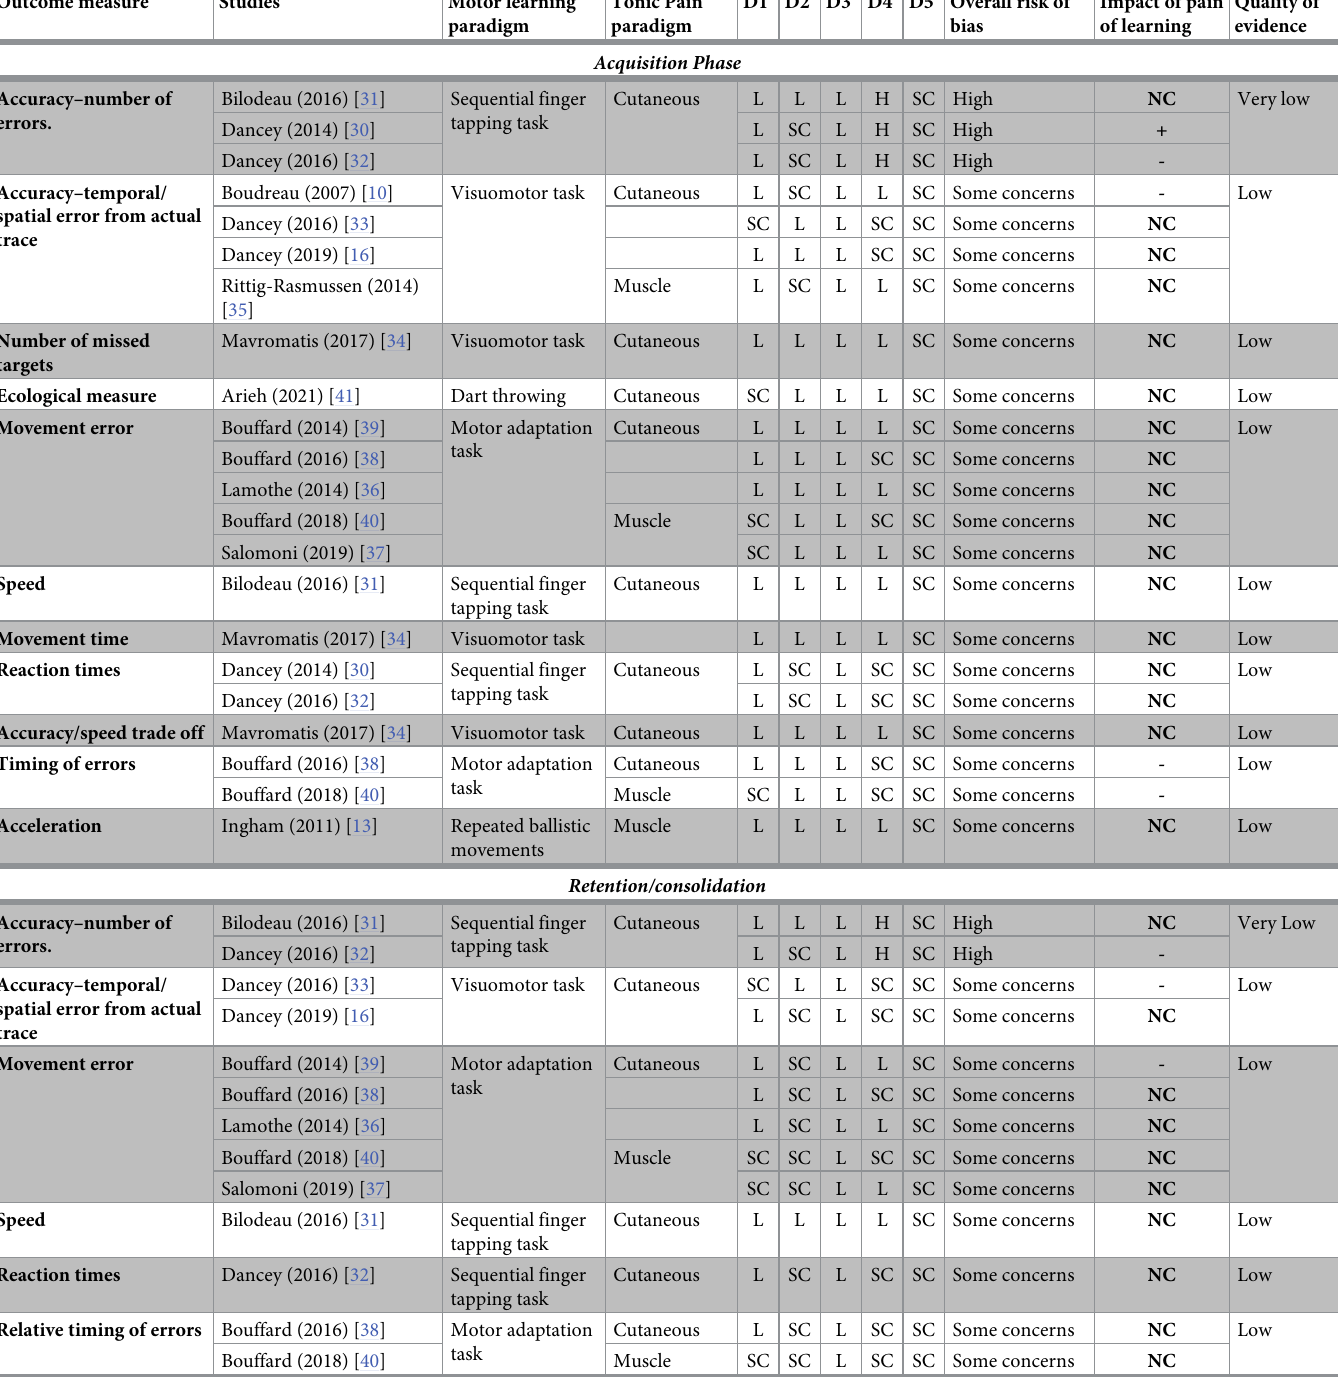
Table 4. Synthesis of evidence, risk of bias judgements and quality of evidence scores for the impact of tonic pain on individual task performance outcome